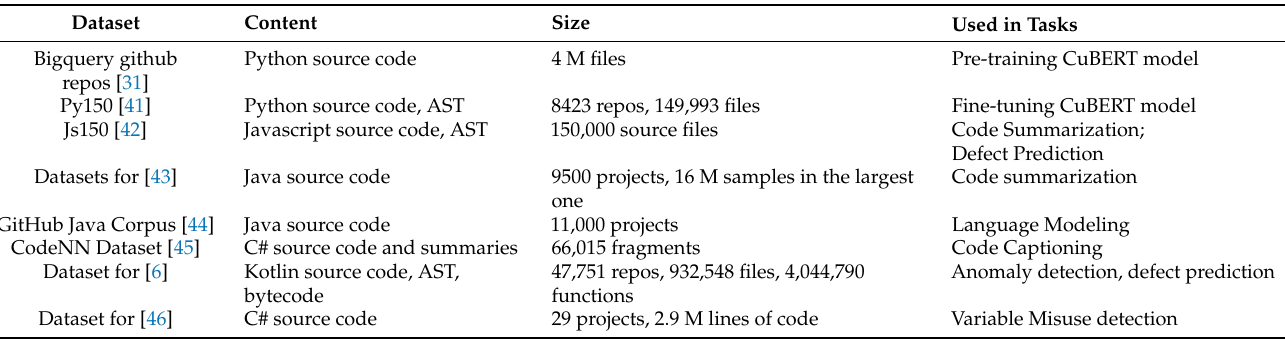
Table 1. List of unlabeled datasets.